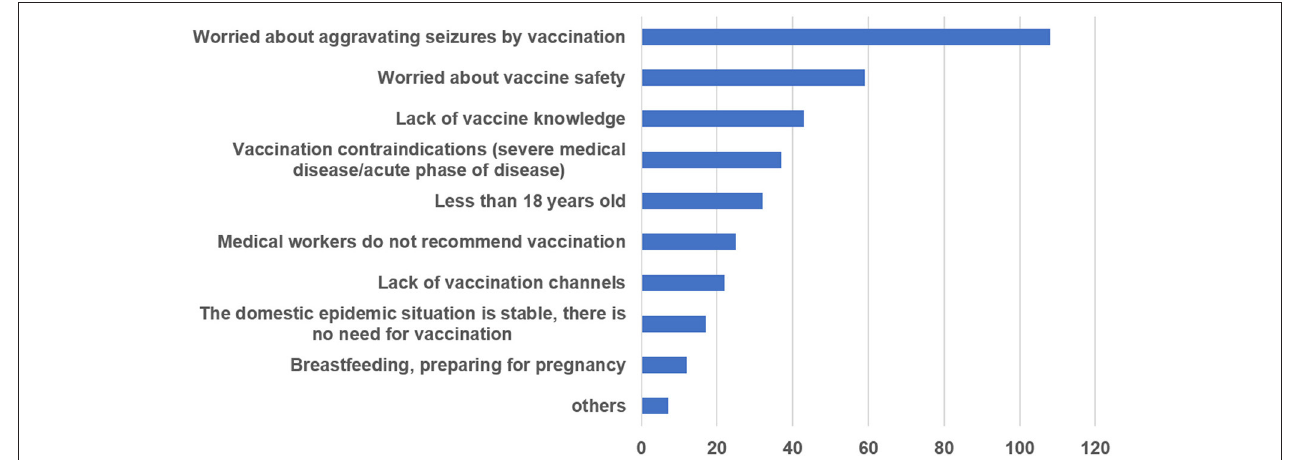
FIGURE 2 | Main reasons for COVID-19 vaccination